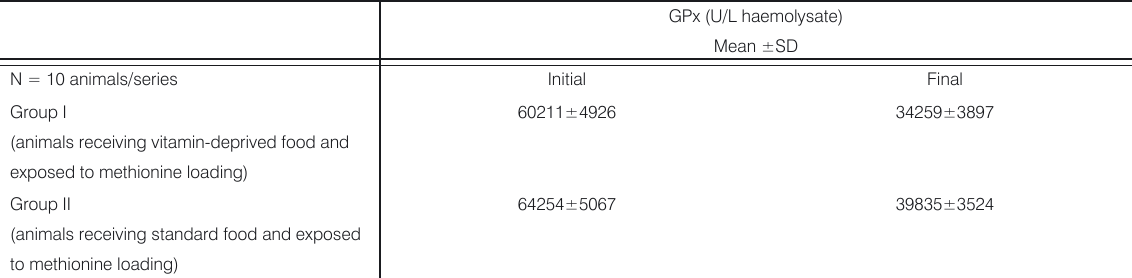
Table 4. Glutathione peroxidase activity, in rat red blood cells, determined initially and after methionine administration for a 15-day period.